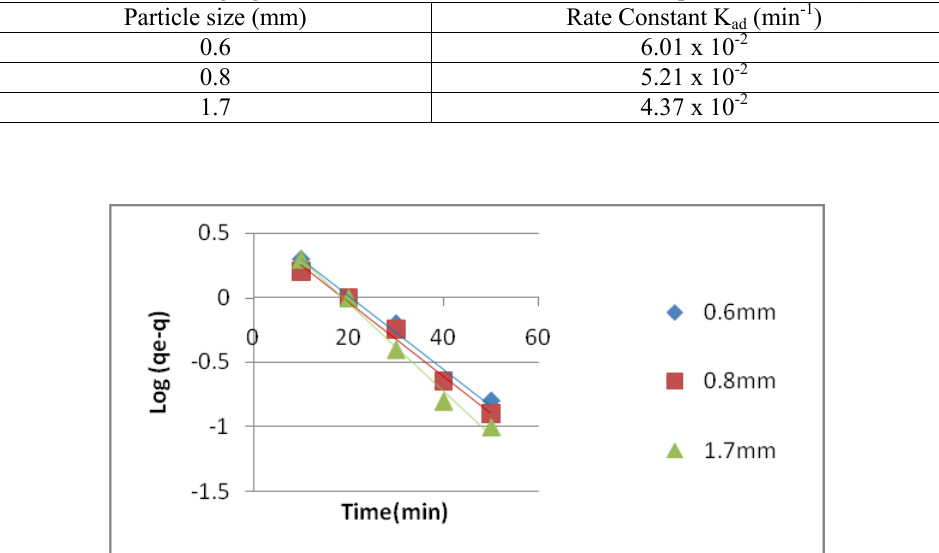
Figure 8. Relationship between different particle size and time of